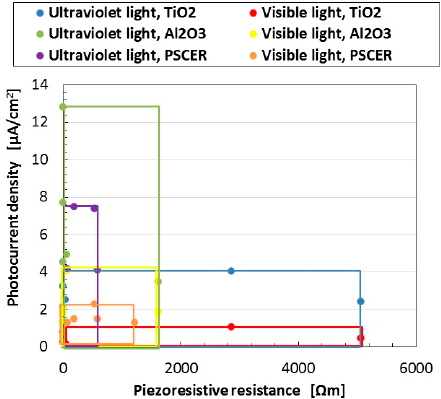
Figure 6. Change in photocurrent density with piezoresistive resistance under visible and ultraviolet irradiation for PSCERs and wet-type MCF rubber solar cells with Al 2 O 3 and TiO 2 electrolytically polymerized under a magnetic field with Ruthenium complexes dye and KI + I 2 electrolyte. Each color indicates the range of values taken by several rubbers at each component. The abscissa in the figure presents specific resistance values at non-irradiation.